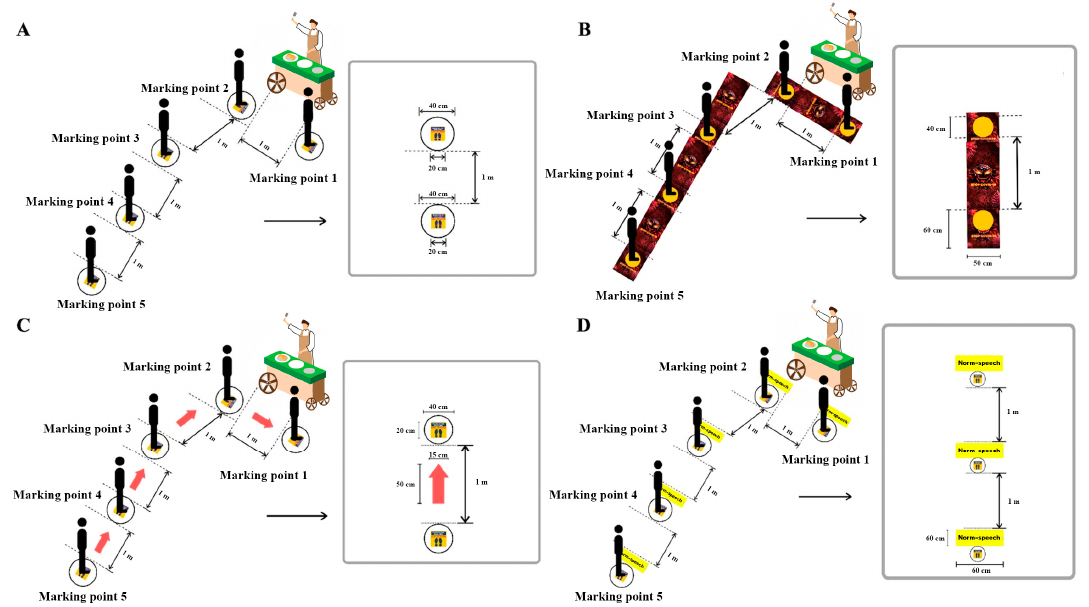
Figure 1. Innovation media: ( A ) Conventional, ( B ) fearful picture, ( C ) red one-way arrow sign, and ( D ) norm-speech sticker (e.g., “Please maintain a distance from other customers”, “Physical distancing and Win COVID-19”, and “Please queue